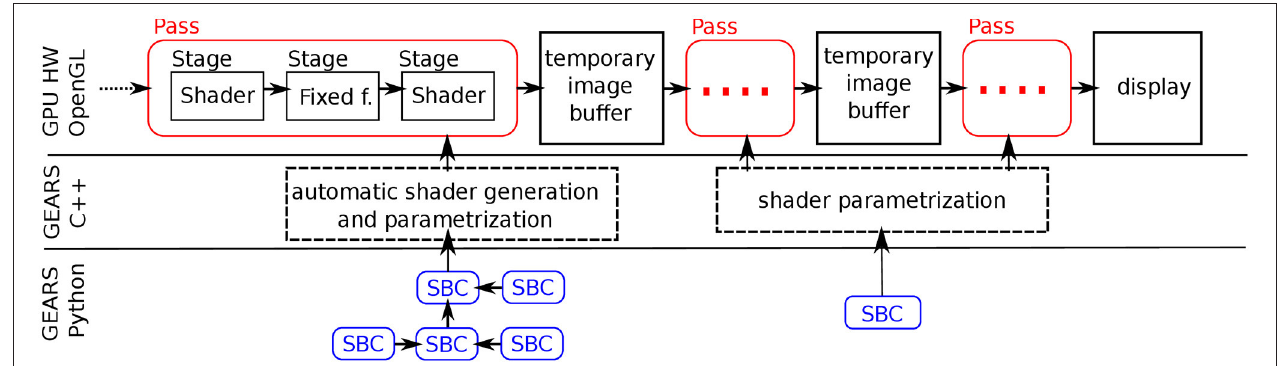
FIGURE 3 | A GPU pass is defined by a full configuration of fixed function stages and programmable shader stages. The GEARS C ++ engine automatically generates shaders, parametrizes fixed function and programmable stages, and constructs the workflow of passes. This process is controlled by Stimulus Building Components (SBCs) that define various aspects of